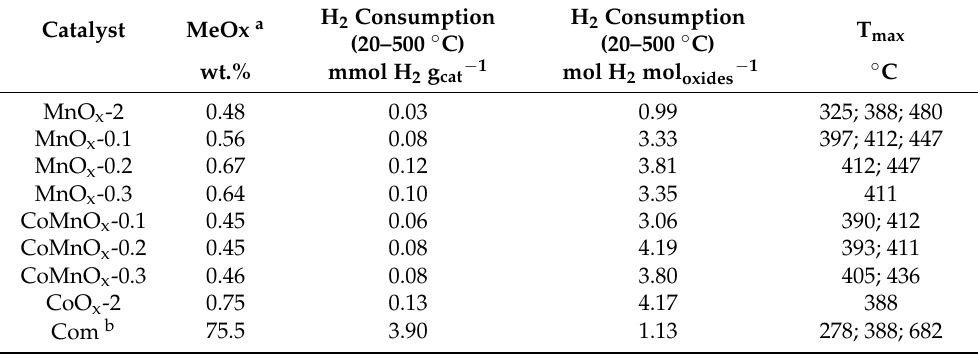
Table 3. Characteristic parameters obtained from the temperature-programmed reduction measurements.